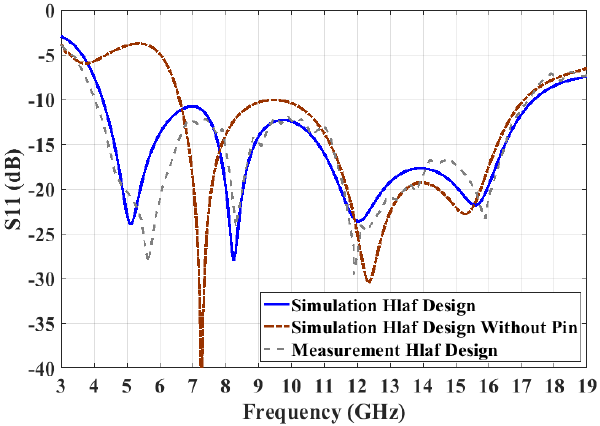
FIGURE 6 . Measurement and simulation results of S-parameters of suggested half structure with half V-shaped slot.